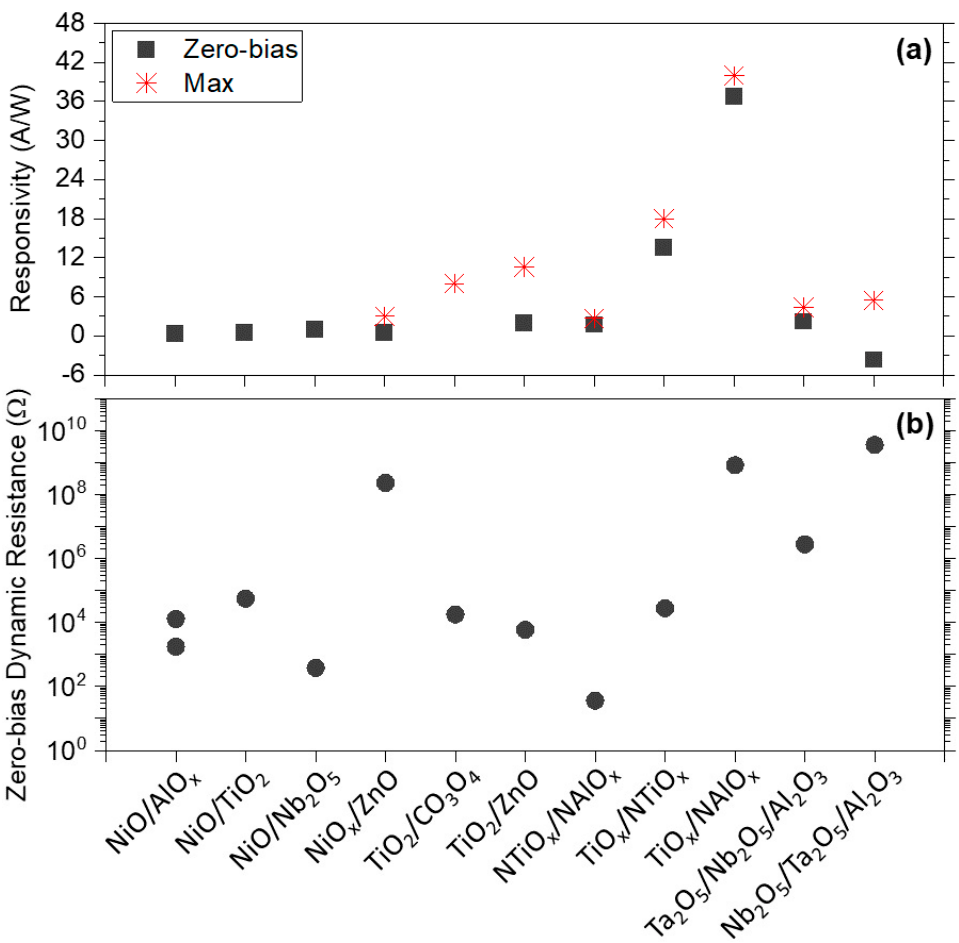
Figure 6. ( a ) Responsivity and ( b ) zero-bias dynamic resistance for MI n M diodes. For full details, please see Table 3.